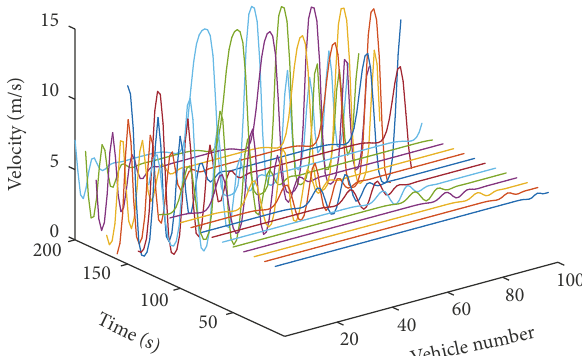
Figure 2: Velocity variation of all vehicles for manual driving.